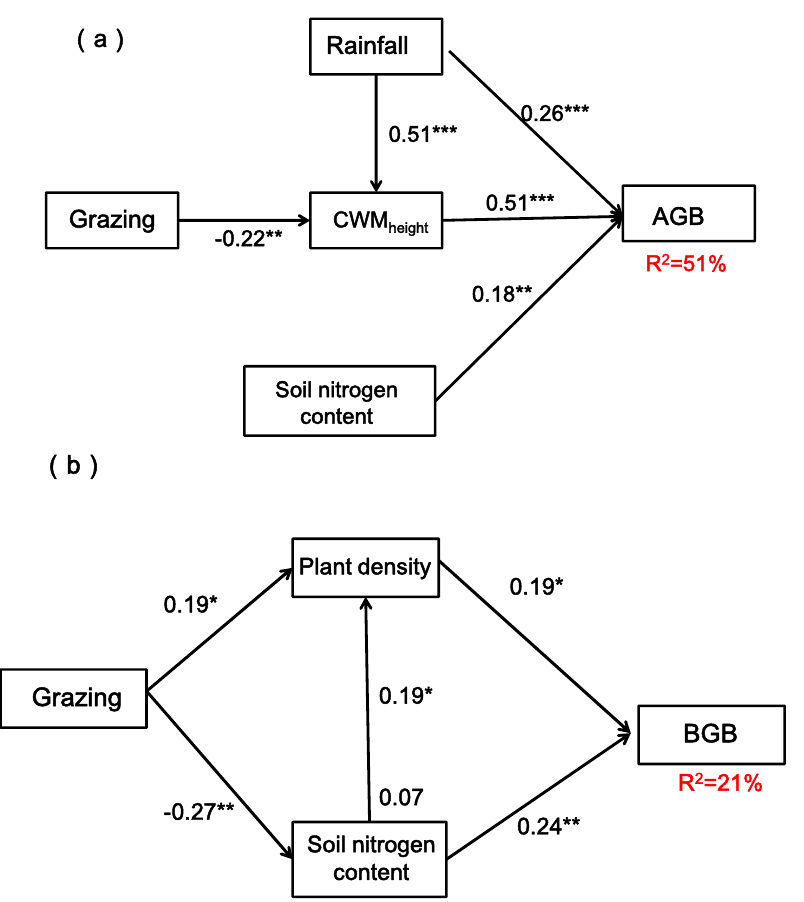
Figure 10. Structural equation model showing all interaction pathways of AGB (aboveground biomass) and BGB (belowground biomass) of grazing, rainfall, soil nitrogen content, plant community height (CWM height ) and plant density. Subfigure ( a ) shows the structural equation model affecting aboveground biomass (AGB); subfigure ( b ) shows the structural equation model affecting belowground biomass (BGB). Note: The single-headed arrows represent paths in this conceptual model; the arrow width is proportional to the strength of the relationship. Standardized regression weights (along the path) and total variance are explained as a result of all predictors pointing to that variable. *, ** and *** indicate statistically significant paths at p < 0.05, p < 0.01 and p < 0.001, respectively.